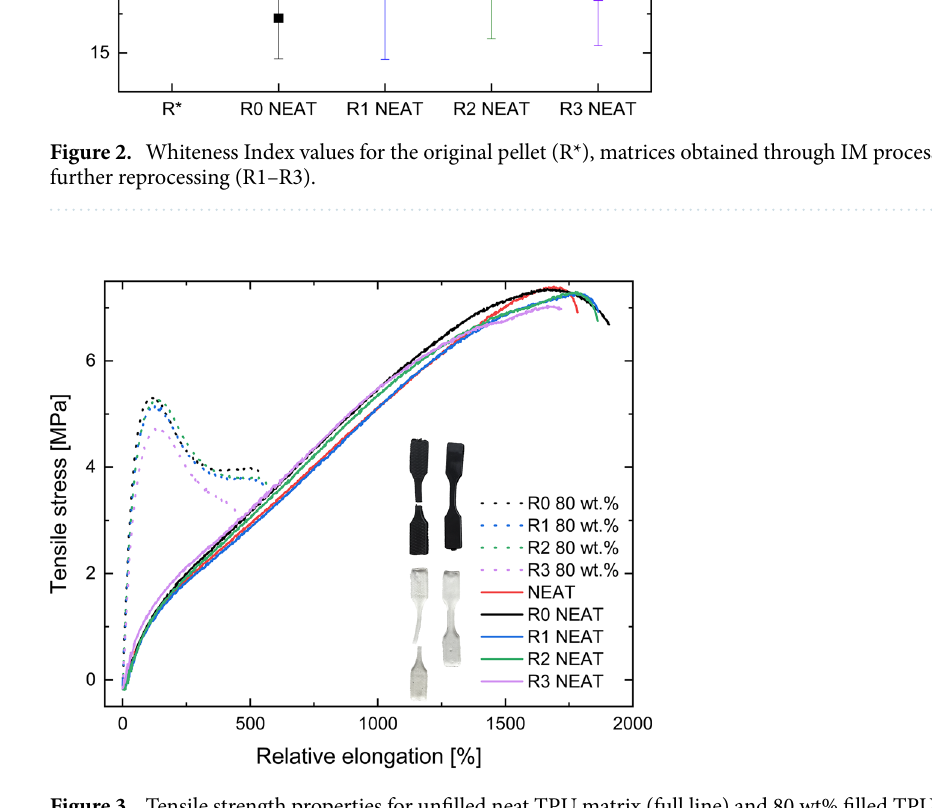
Figure 3. Tensile strength properties for unfilled neat TPU matrix (full line) and 80 wt% filled TPU matrix (dot